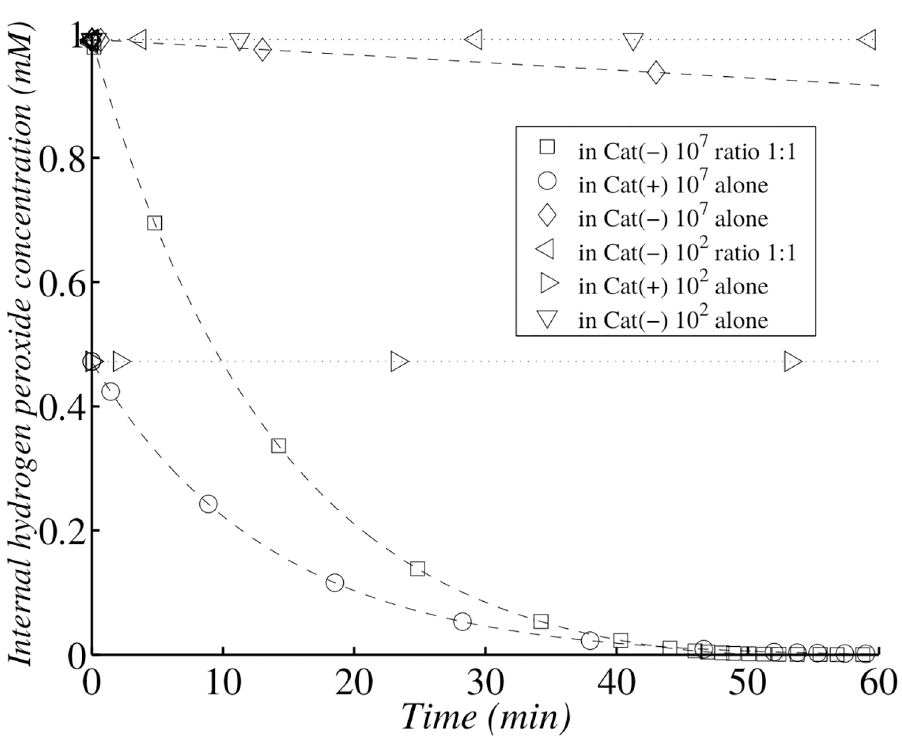
Fig 15. Simulation of Ma and Eaton experiment following internal hydrogen peroxide concentration. Simulation of H 2 O 2 internal concentration change with dilute (10 2 cells per ml) Cat(-) E. coli alone ( ! ) or Cat (+) E. coli alone ( ⊳ ) or admixed with equal numbers of Cat(+), Cat(-) E. coli ( ⊲ ); and with concentrated (10 7 cells per ml) Cat(-) E. coli alone ( (cid:12) ) or Cat(+) E. coli alone ( (cid:10) ) or admixed with equal numbers of Cat(+), Cat(-) O fi nal concentration of 1.0 mM, and the bacterial suspension E. coli ( & ). At zero time, H 2 2 was added to a was then incubated at